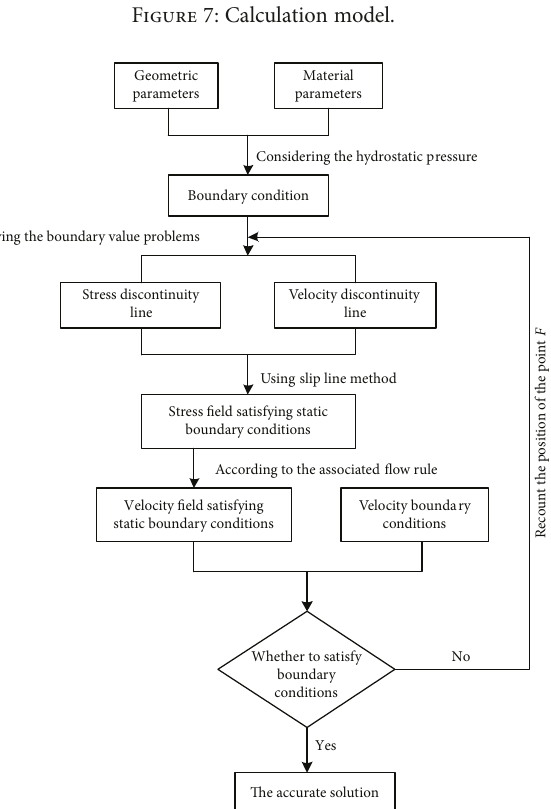
Figure 7: Calculation model.